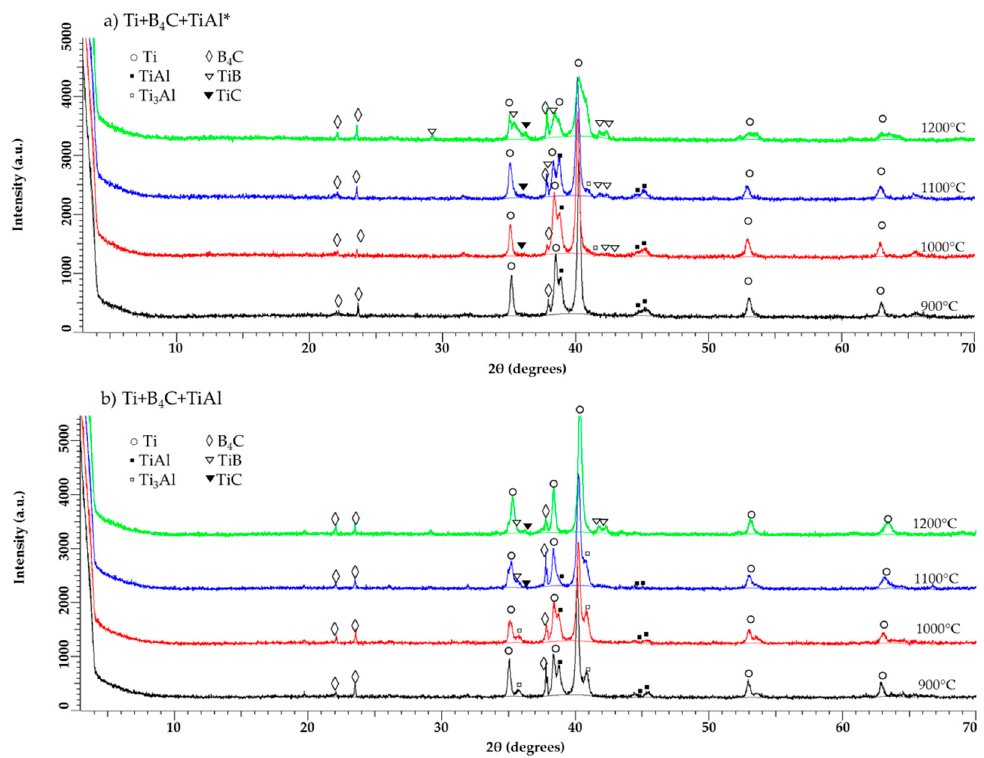
Figure 4. XRD patterns of the TMCs processed under 80 MPa for 5 min, from the starting materials: ( a ) Ti matrix with TiAl* and B 4 C particles; ( b ) Ti matrix with TiAl and B 4 C particles. Table 3. Reference Intensity Ratio (RIR) semi-quantification analysis of TMCs manufactured at 80 MPa and at different temperatures (by iHP).